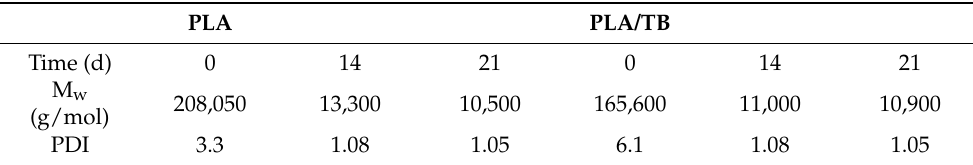
Table 4. Changes in molecular weight (M w ) and polydispersity index (PDI) due to composting of PLA and PLA/TB films. PLA